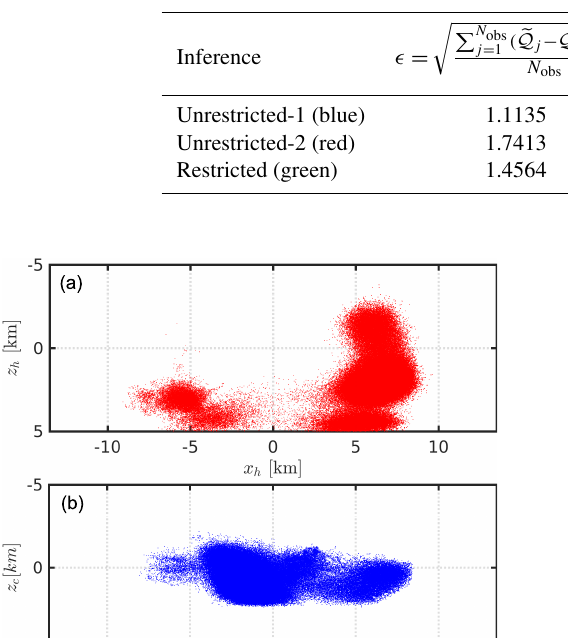
Table 3. Comparison of PC-predicted PGVs of different inferred configurations with the reference GMPE curve. Unrestricted-1 and -2 correspond to inferences in Figs. 10 and 11, respectively. Each inferred configuration leads to PGV predictions in Fig. 15, as indicated by different colors.